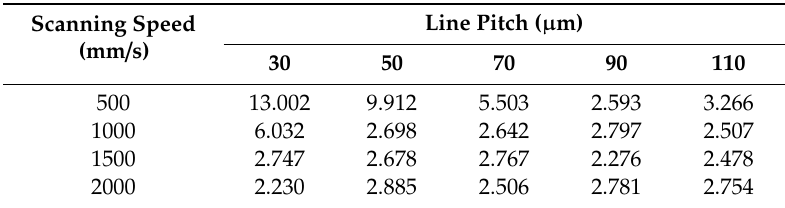
Table 3. Surface roughness (Ra) of mesh patterns on the XO RGP contact lens treated by different laser scanning speeds and line pitches (Unit: μ m).